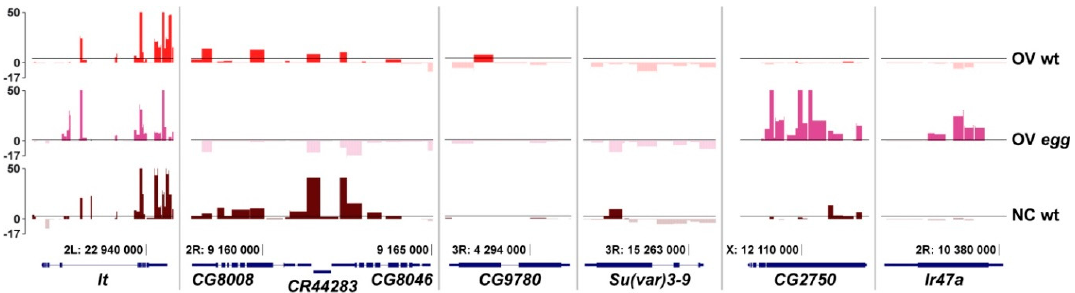
Figure 5. SU(VAR)3-9 binding profiles across select genes depending on the developmental stage of the ovary and the genotype: germline cells of juvenile ovaries of wild type females (OV wt) and egg mutants (OV egg ) or mature nurse cells of wild type (NC wt). Data for NC wt are taken from [28], the rest of the profiles are obtained in this study. Axis labels are the same as in Figure 2.